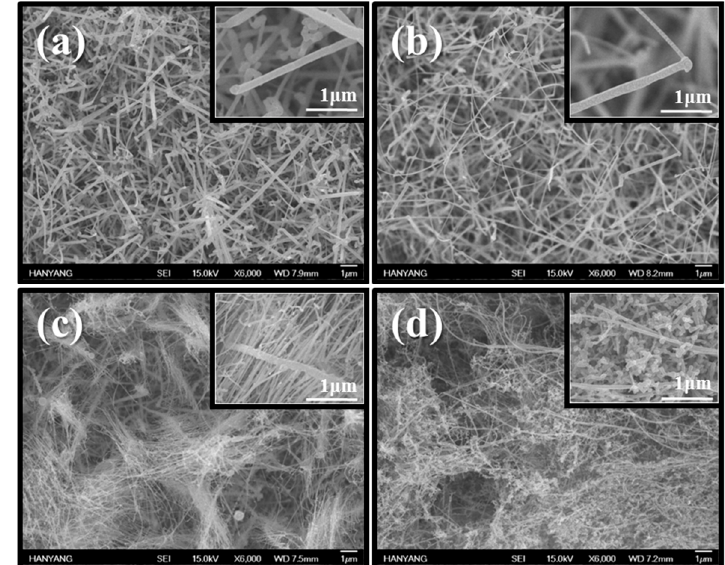
Figure 1. SEM images of ( a ) SnO 2 nanowires, TeO 2 branched SnO 2 nanowires with annealed at ( b ) 320 °C, ( c ) 370 °C, and ( d ) 420